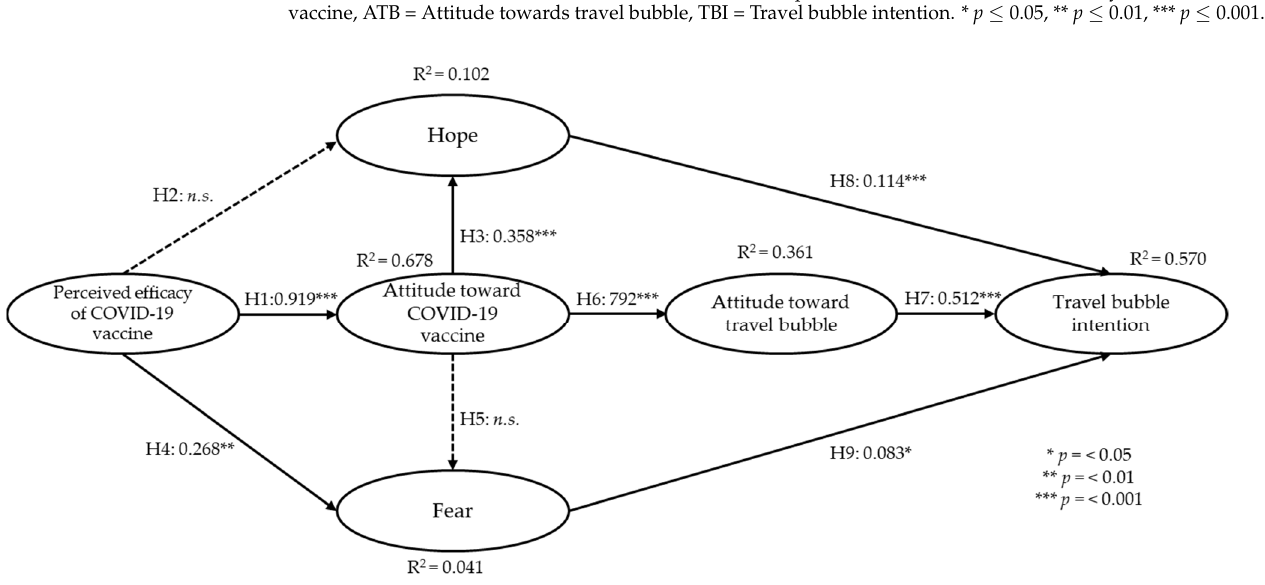
Figure 2. Conceptual model and the results of structural equation modeling.